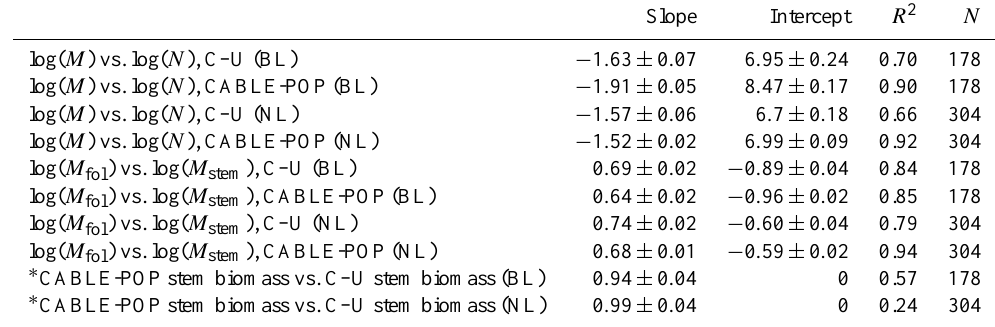
Table 2. Reduced major axis regression coefficients associated with biomass–density, leaf–stem allometry and stem biomass plots of Fig. 4.